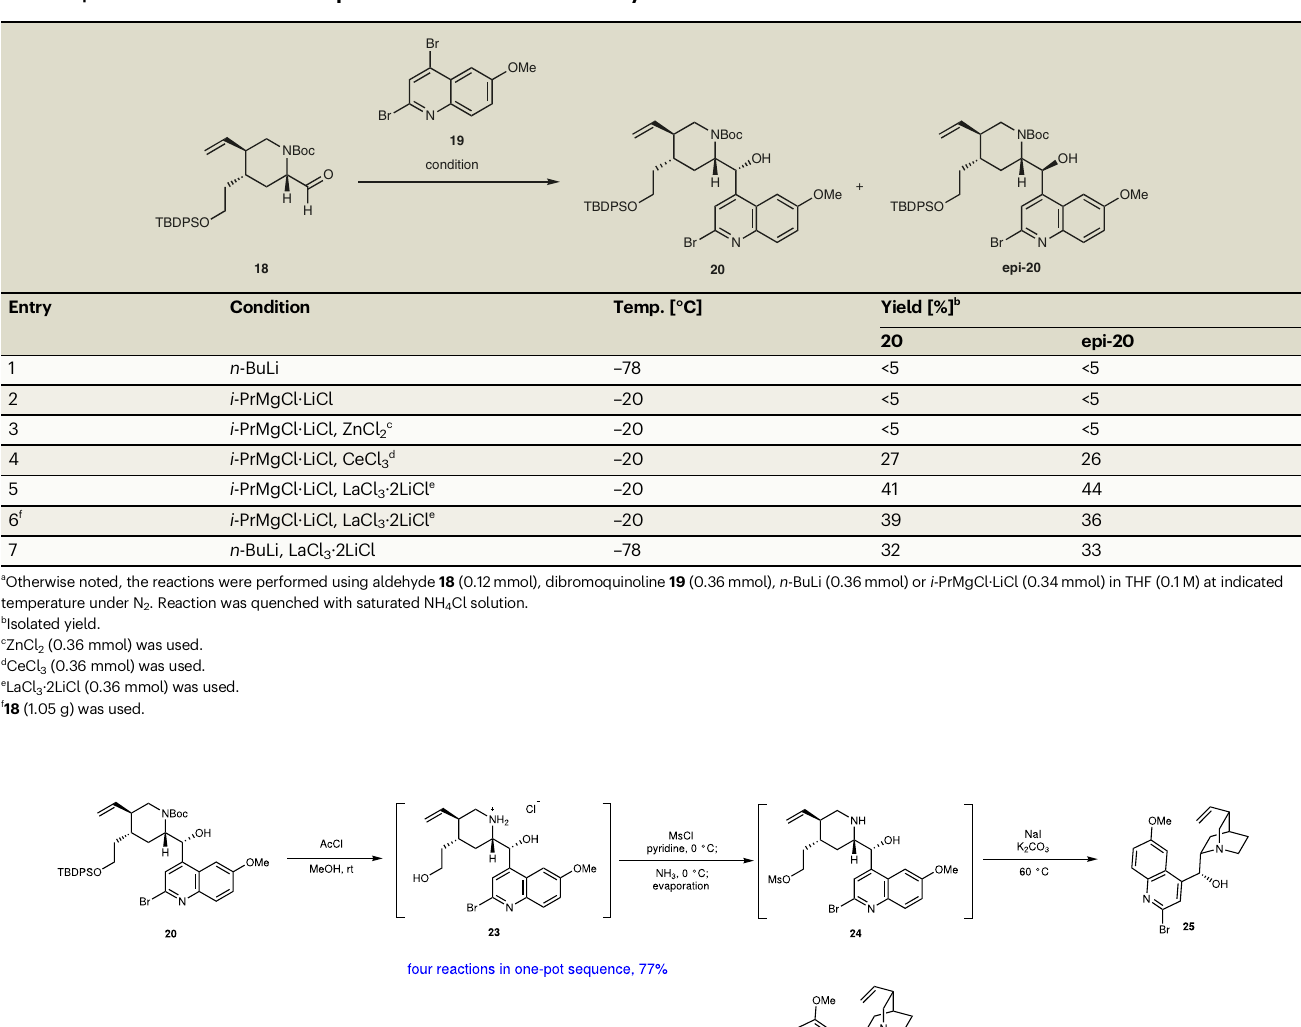
Table 1 | Addition reaction of a quinoline derivative to aldehyde 18 a